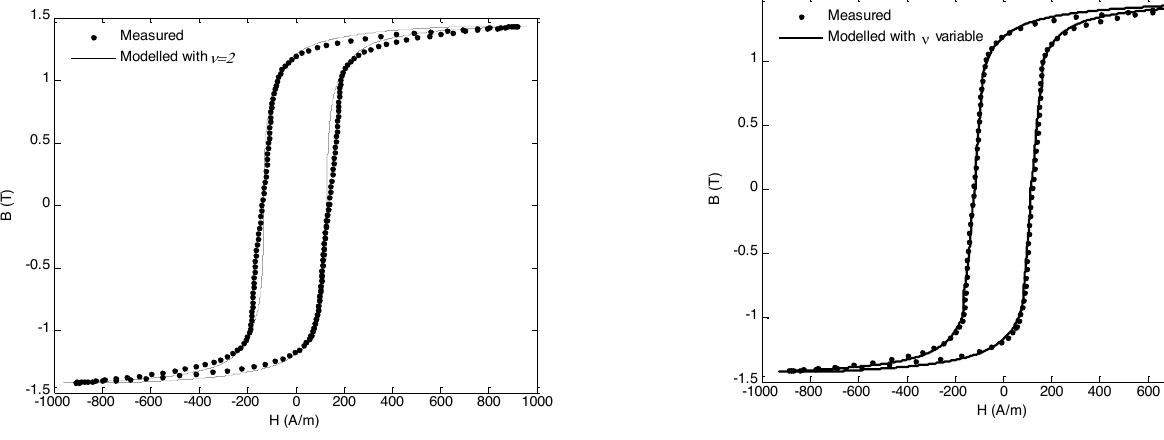
FIGURE 5. Modelled and measured hysteresis loops at 250 Hz